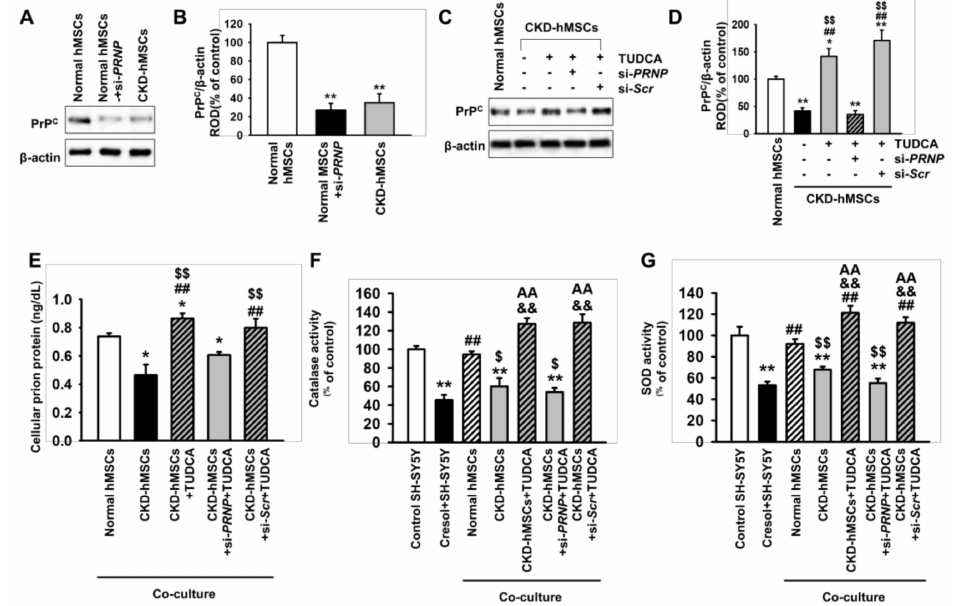
Figure 2. Co-culture of SH-SY5Y cells with TUDCA-stimulated Chronic kidney disease (CKD-hMSCs) increases the activity of anti-oxidant enzymes via upregulation of PrP C . ( A ) Western blot showing the expression of cellular prion protein (PrP C ) in normal human MSCs (hMSCs), normal hMSCs pretreated with PRNP (PRioN Protein) siRNA (si- PRNP ) for 48 h, and hMSCs isolated from a CKD patient (CKD-hMSCs) ( n = 3). ( B ) The level of PrP C in ( A ) was determined by densitometry relative to β -actin. ( C ) Western blot showing the expression of PrP C in CKD-hMSCs pretreated with TUDCA (1 µ M) for 24 h. CKD-hMSCs were pretreated with PRNP siRNA (si- PRNP ) or Scramble siRNA (si- SCR ) for 48 h, then treated with TUDCA ( n = 3). ( D ) The expression of PrP C was determined by densitometry relative to β -actin. ( E ) The concentration of PrP C in SH-SY5Y cells after co-culture with hMSCs ( n = 5). (F and G) Catalase ( F ) and SOD activity ( G ) in SH-SY5Y cells following co-culture with hMSCs. Statistical analysis: Values represent the mean ± SEM. ( B ) ** p < 0.01 vs. normal hMSCs. ( D ) ** p < 0.01 vs. normal hMSCs, ## p < 0.01 vs. CKD-hMSCs, $$ p < 0.01 vs. TUDCA-treated CKD-hMSCs pretreated with si- PRNP . ( F ) * p < 0.05 vs. normal MSCs, ## p < 0.01 vs. CKD-hMSCs, $$ p < 0.01 vs. CKD-hMSCs + si- PRNP + TUDCA. ( F and G ) ** p < 0.01 vs. control SH-SY5Y cells without co-culture, ## p < 0.01 vs. P -cresol+SH-SY5Y without co-culture, $ p < 0.05, $$ p < 0.01 vs. co-culture with normal hMSCs, && p < 0.01 vs. co-culture with CKD-hMSCs, AA p < 0.01 vs. co-culture with CKD-hMSCs + si- PRNP +